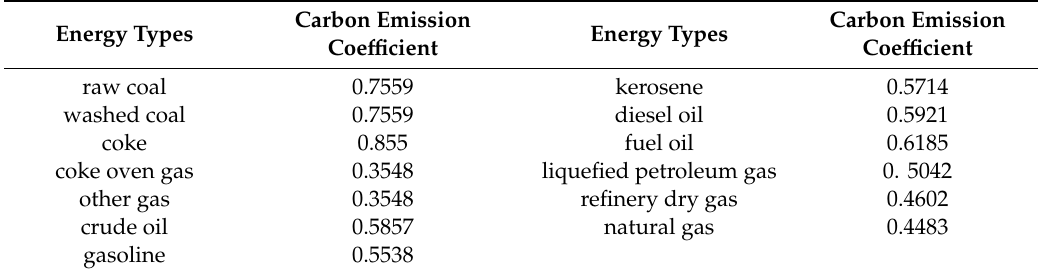
Table 2. Carbon emission coe ffi cient for 13 energy